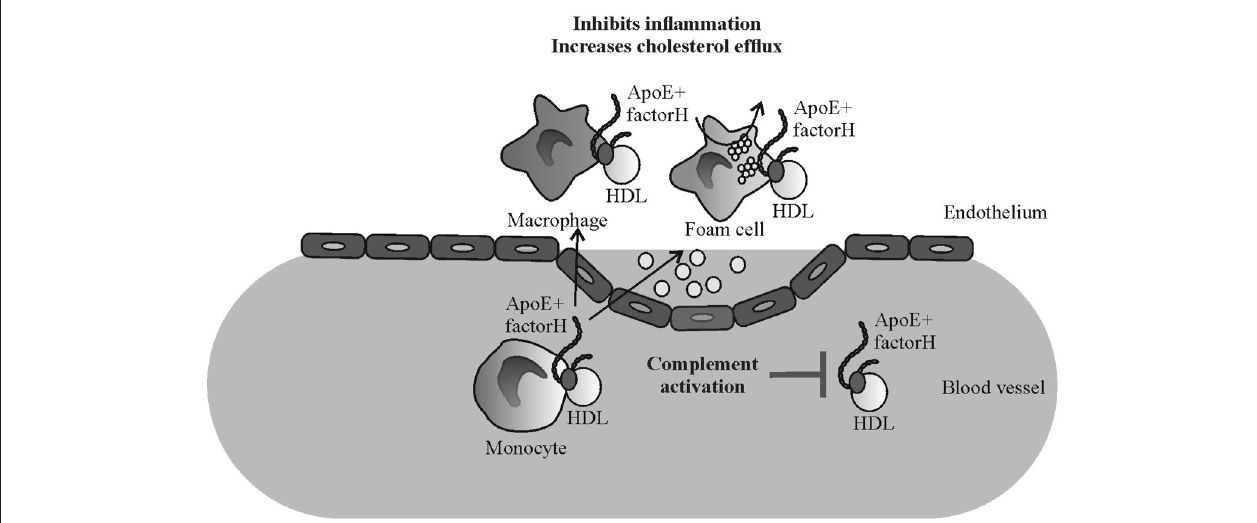
FIGURE 6 | Schematic illustrating the putative mechanism of the effect of factor H-apoE interaction in reducing inflammation in atherosclerotic lesions. Binding of factor H on apoE containing HDL particles reduces plasma complement activation ( 21) while elevated binding of apoE on monocytes/macrophages/foam cells via FH might reduce local inflammation and cholesterol